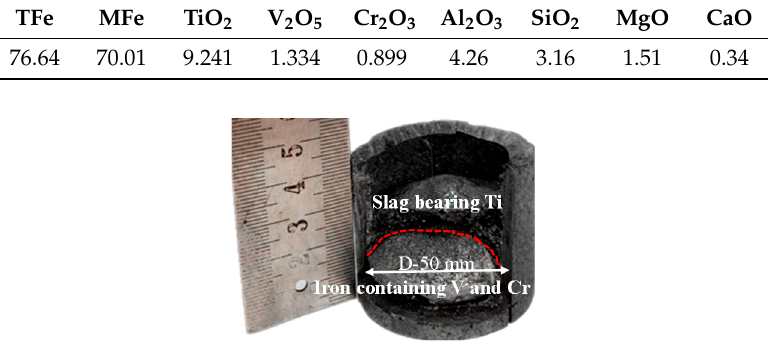
Table 6. Main chemical compositions of separated iron and slag (wt %).